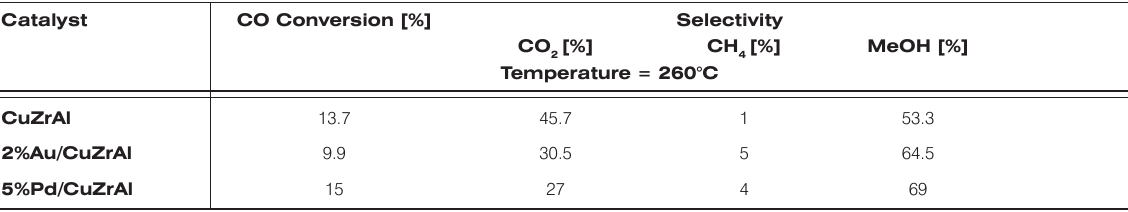
over promoted and unpromoted CuZrAl catalysts. 2